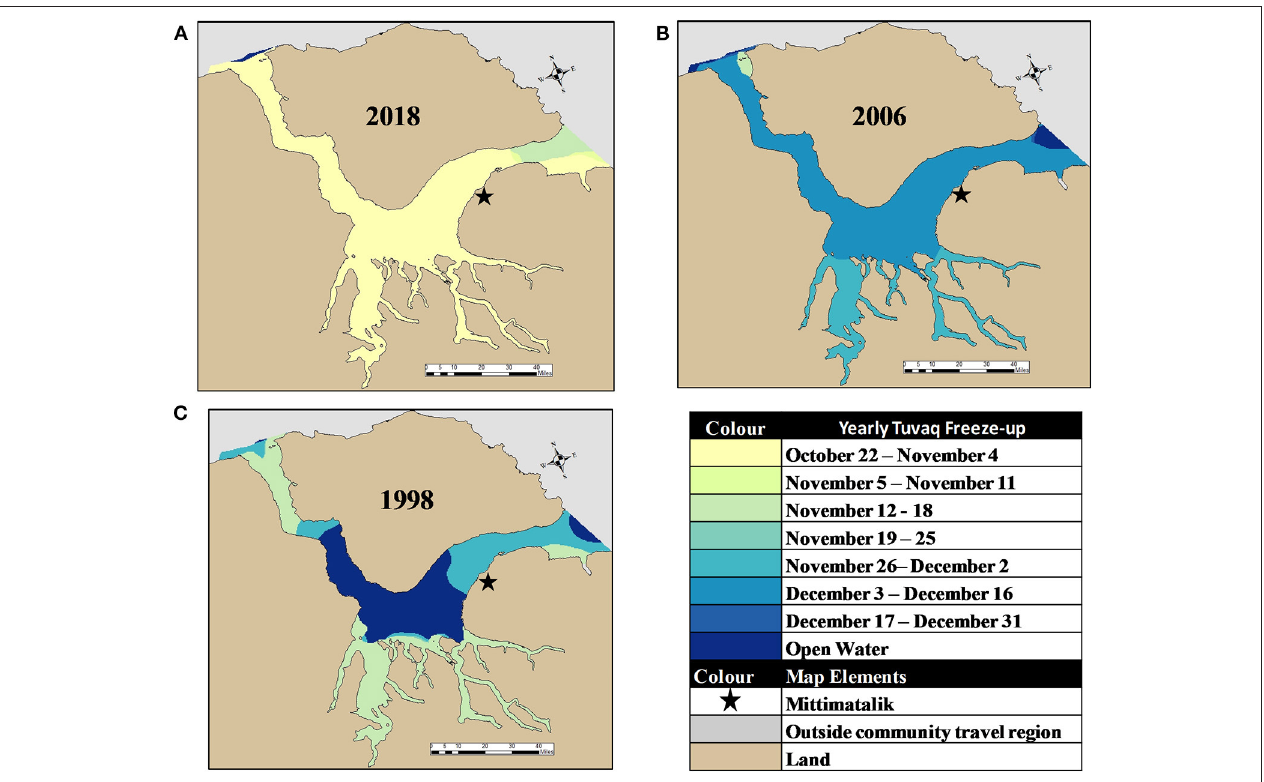
FIGURE 8 | Yearly maps showing the spatial formation of tuvaq for the Mittimatalik region. (A) Example from 2018 showing the weekly freeze-up spatial pattern during years when the tuvaq formation was unusually early. (B) An example from 2006 showing of the weekly freeze-up spatial pattern during years when the tuvaq formation was unusually late. (C) The one exception to the normal freeze-up pattern in 1998 when tuvaq formed last in Eclipse Sound.